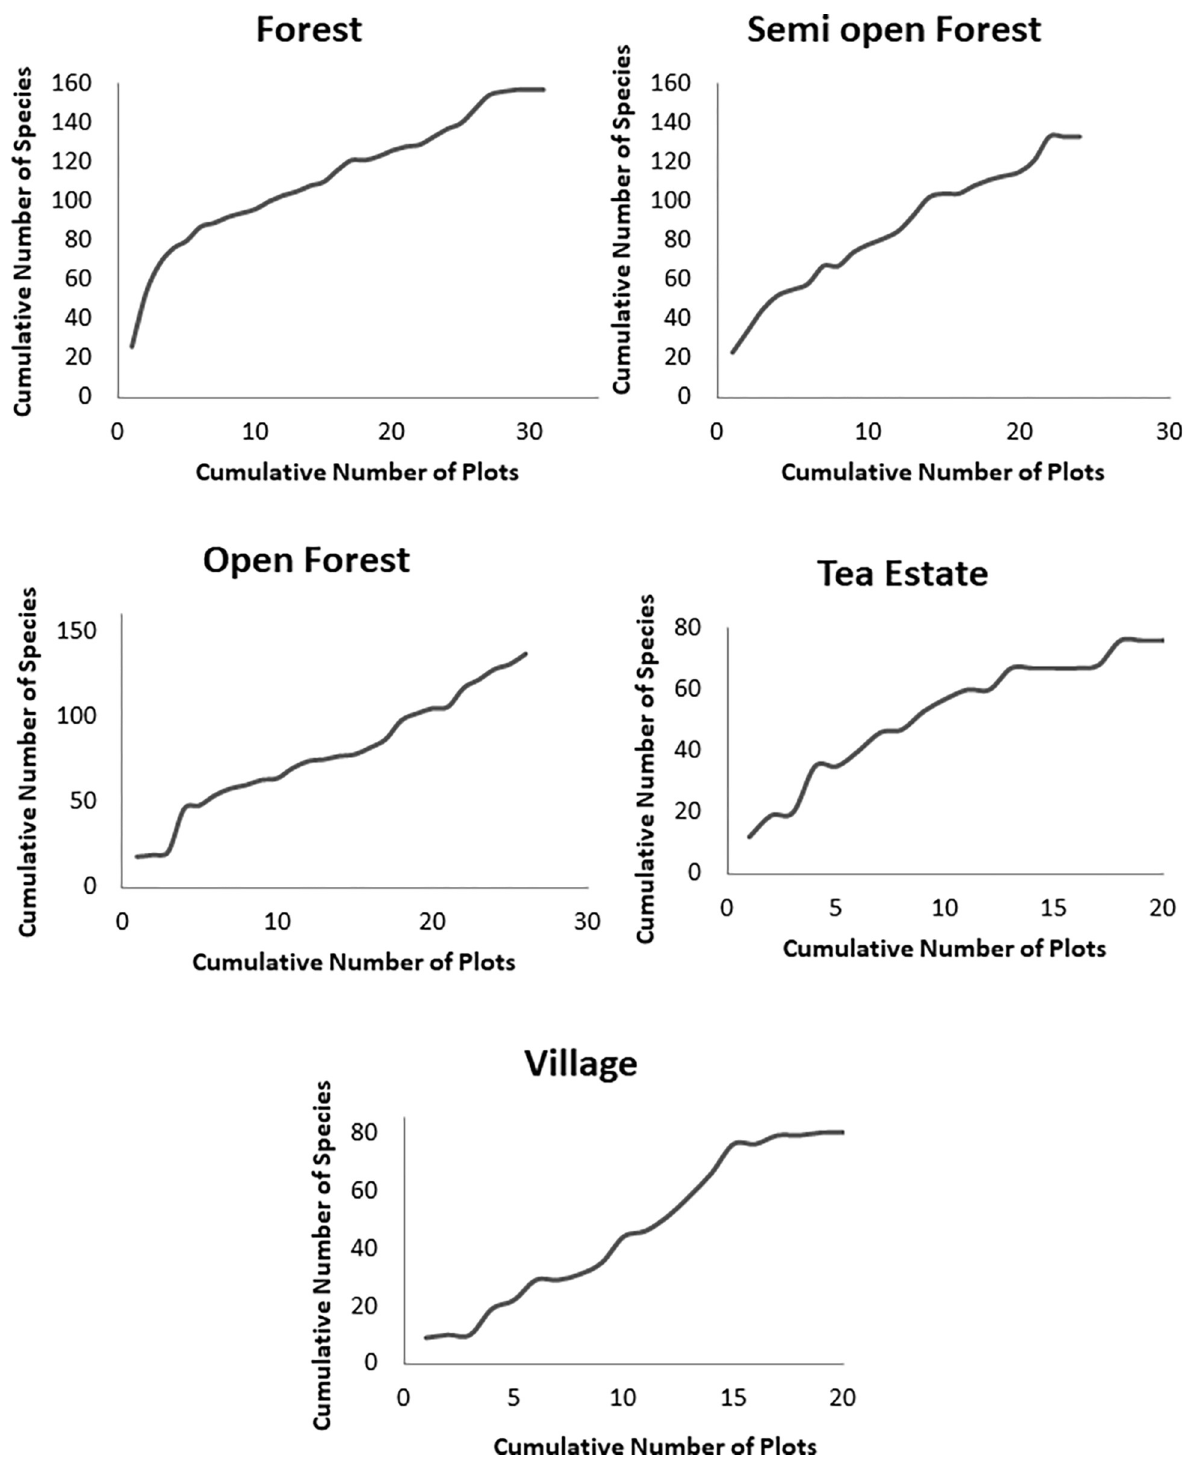
Fig 3. Species accumulation curve for plant species available in the forest, semi-open forest, open forest, tea estate, and village.